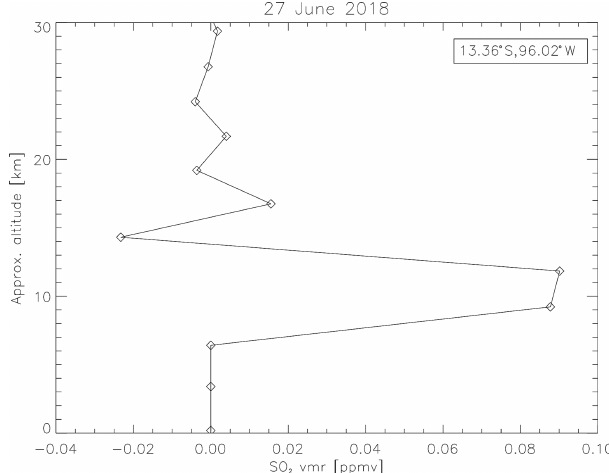
Figure 11. MLS SO 2 profile measured on 27 June 2018 (at a mea- surement time of 20:16UTC) in the extended volcanic plume from the Sierra Negra eruption, clearly showing the presence of an SO 2 layer at an altitude range from 9 to 11km. The position of the mea- surements is shown in Fig.